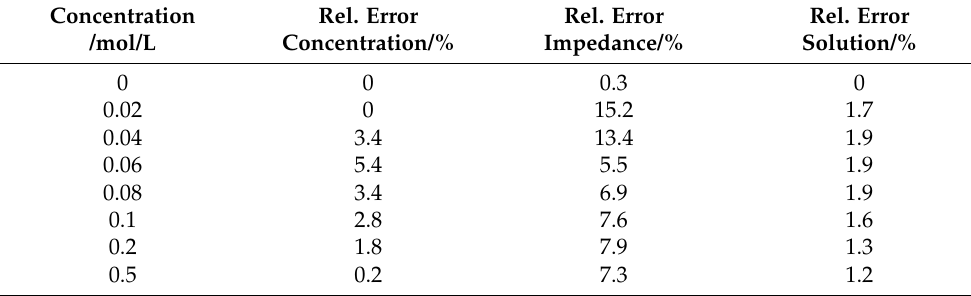
Table 6. Error between titration measurement and sweep measurement of Geo10. Concentration